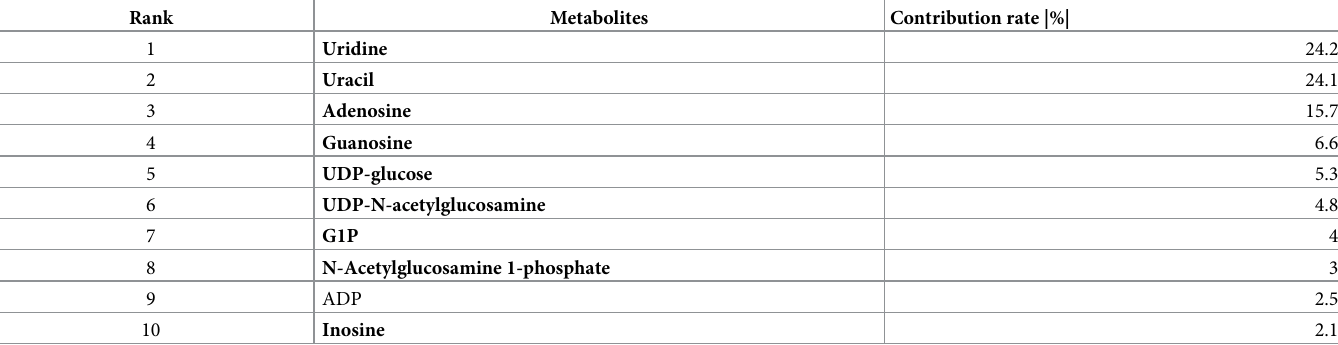
Table 2. Top ten absolute values of contribution rates to changes in the amount of ionic metabolites in EVs after IFN- γ exposure.